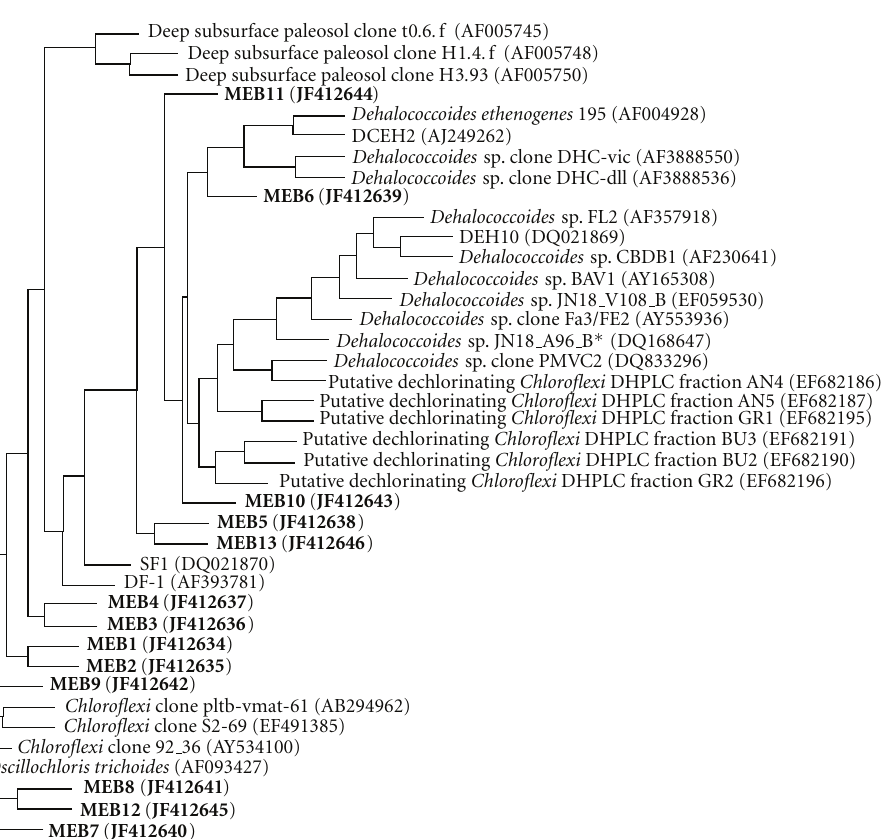
Figure 2: Phylogenetic tree showing the relationships between the dominant phylotypes identified in sediment samples Meb6, Meb7, and Meb8 (bold) and the closest dechlorinating species within the dechlorinating Chloroflexi group. Phylotypes from sample Meb6, Meb7 and Meb8 were located throughout the phylogenetic tree and did not show any relationship between the sample origins their phylogenetic relationship. Accession numbers are indicated in parentheses. The tree was calculated by the neighbor joining method and supported by FITCH [43]. The scale bar indicates 10 substitutions per 100 nucleotide